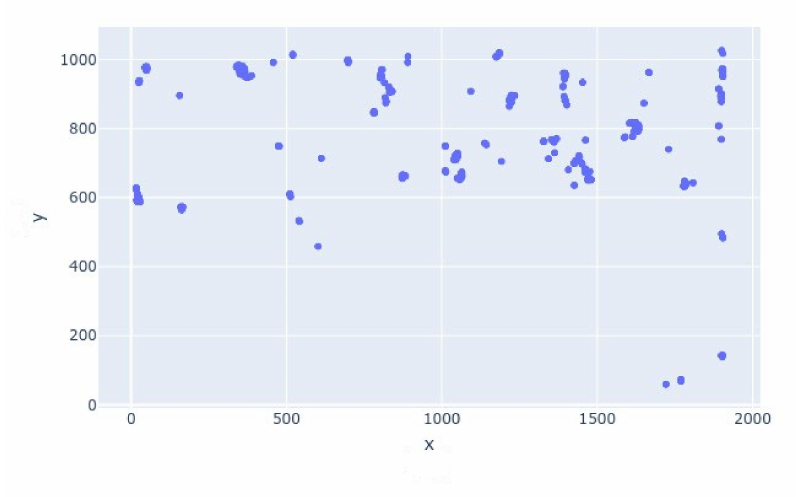
Figure 5. The clustered graphical representation of the detections done by the proposed framework.